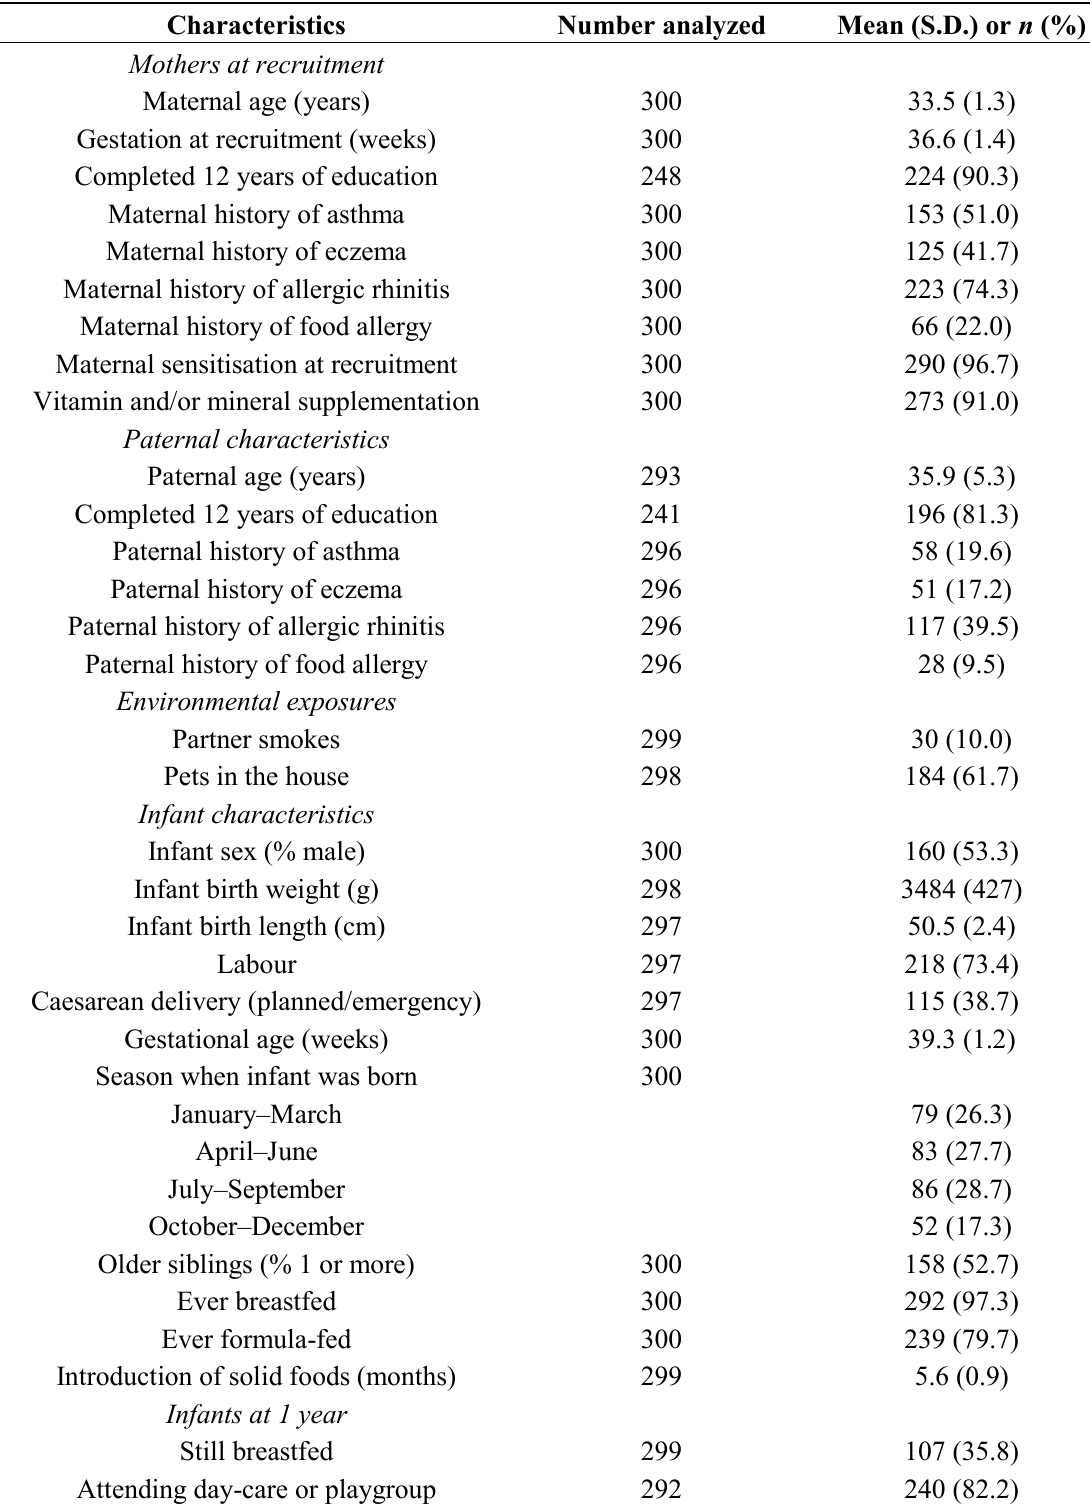
Table 1. Population characteristics of 300 mother-infant